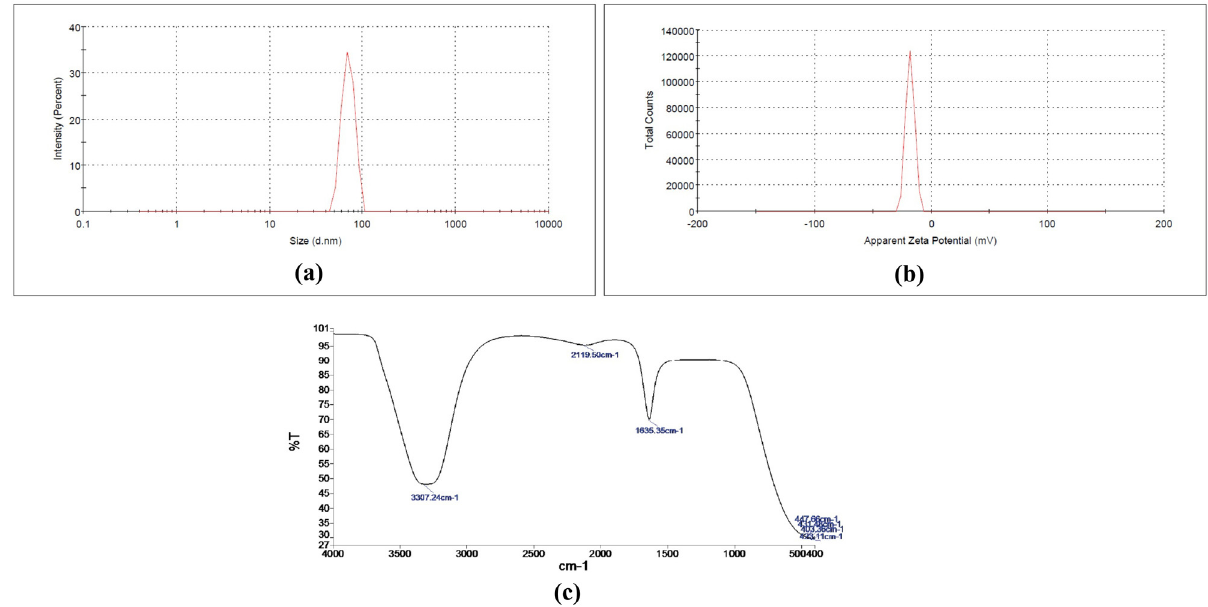
Figure 1: The characterization of Rut - loaded SeNPs: ( a ) size distribution by intesnsity, ( b ) zeta potential distribution, and ( c ) FT - IR.